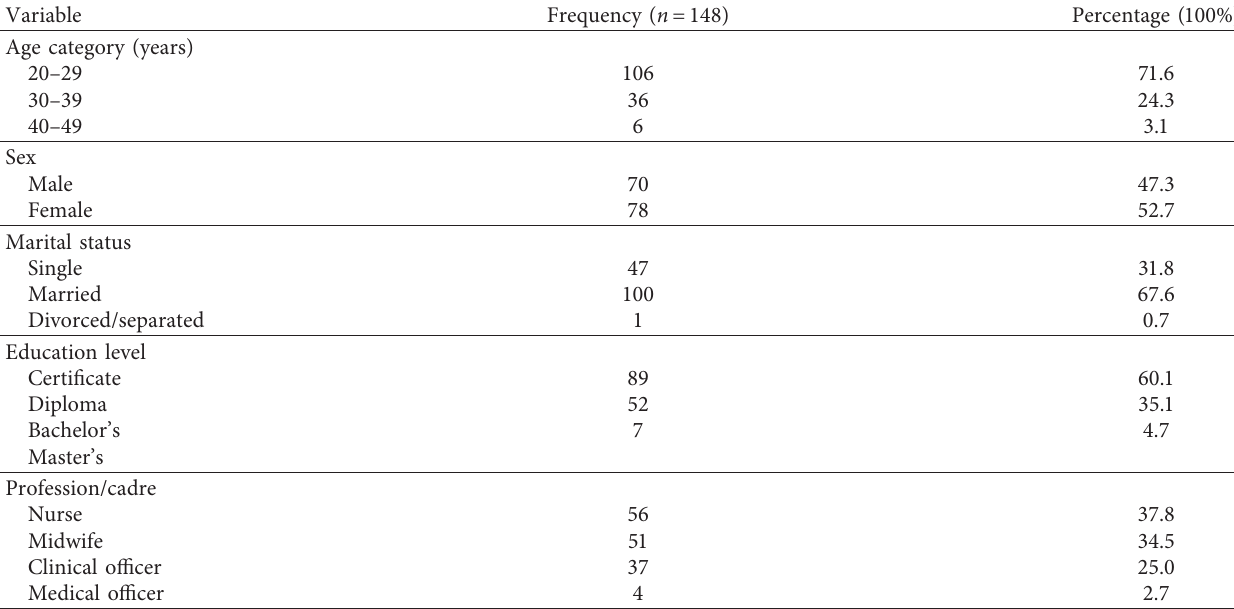
Table 4: Sociodemographic characteristics of healthcare